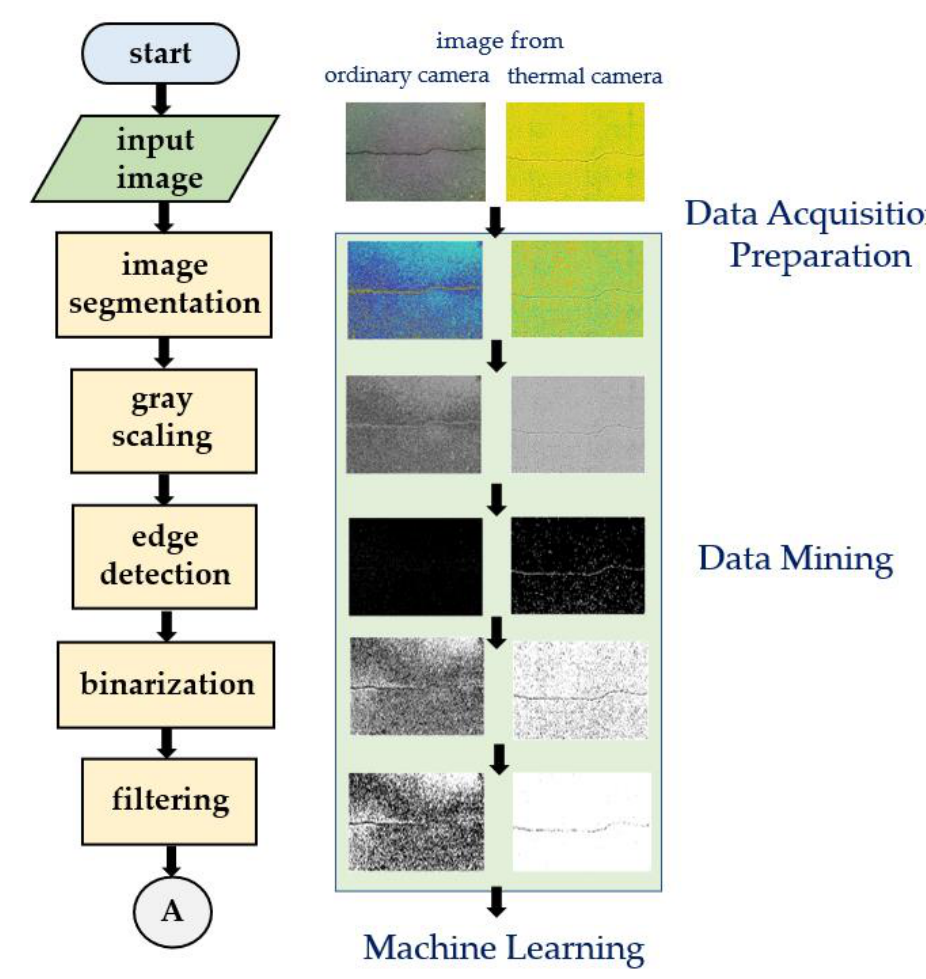
Figure 5. Proposed flowchart of the image-processing techniques.